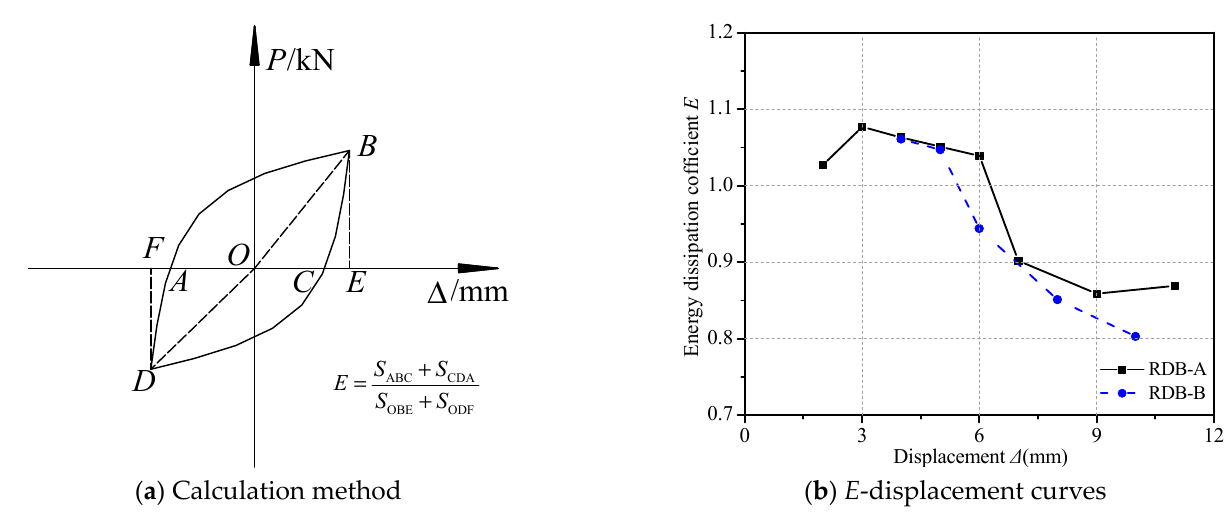
Figure 8. Energy dissipation results of test specimens.